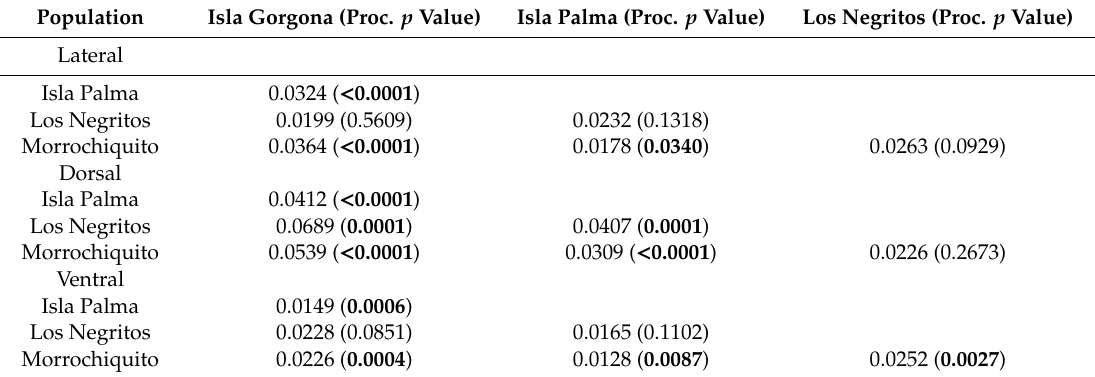
Table 1. Results of the Canonical Variate analysis with Procrustes distances and the respective p values, for the respective views and populations of Lottia mesoleuca . Statistical significant values are in